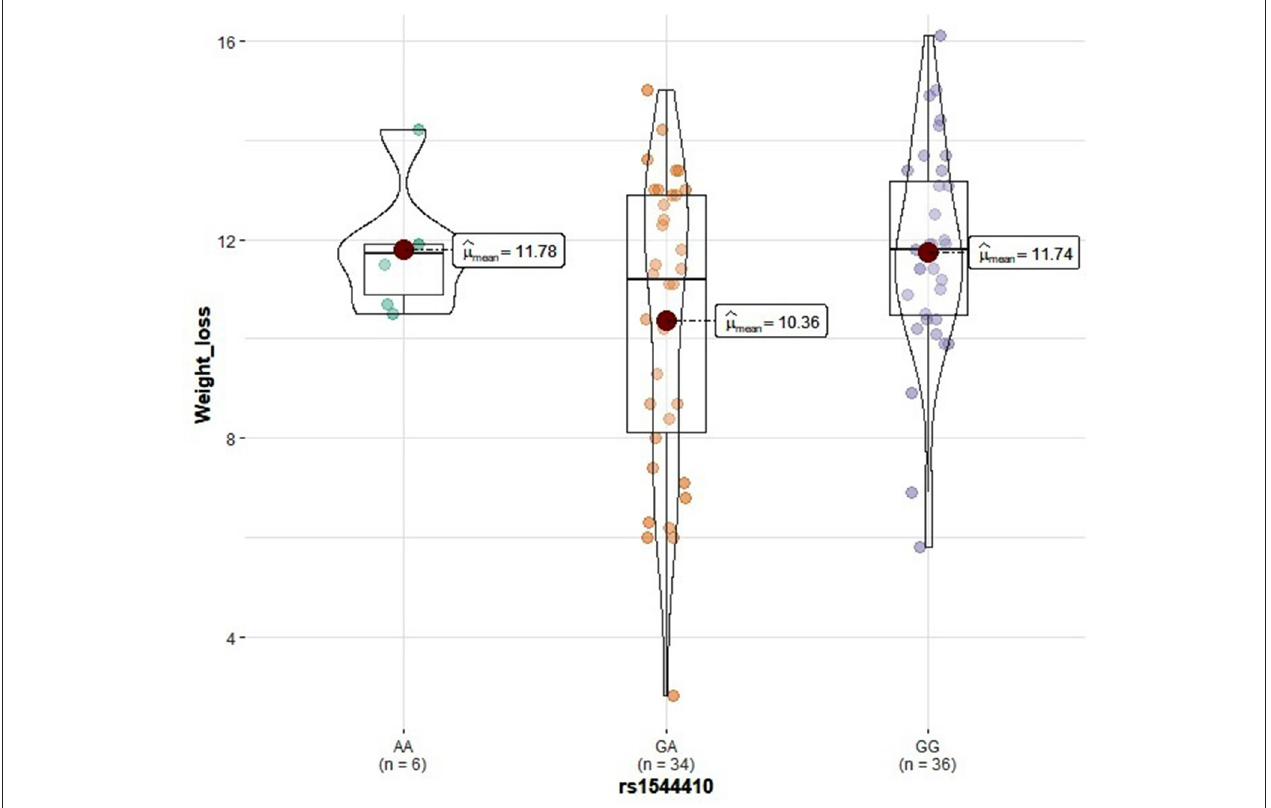
FIGURE 5 | Violin plots displaying the mean values of weight loss in the control group according to rs1544410 genotype